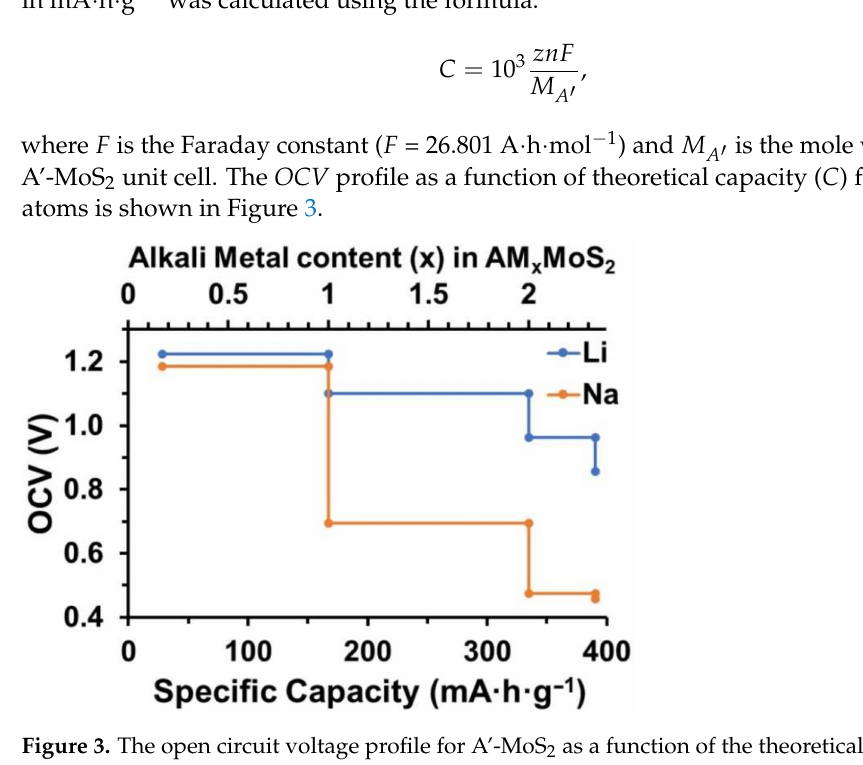
Figure 3. The open circuit voltage profile for A’-MoS 2 as a function of the theoretical capacity of Li (blue) and Na